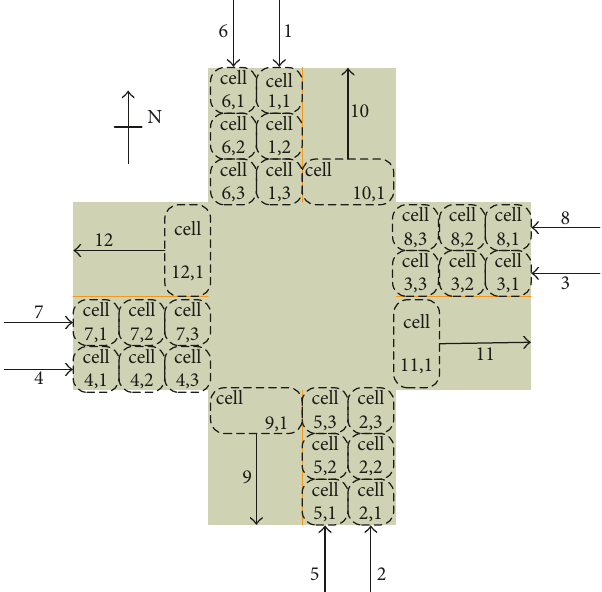
Figure 1: Schematic diagram of the single intersection four-phase CTM